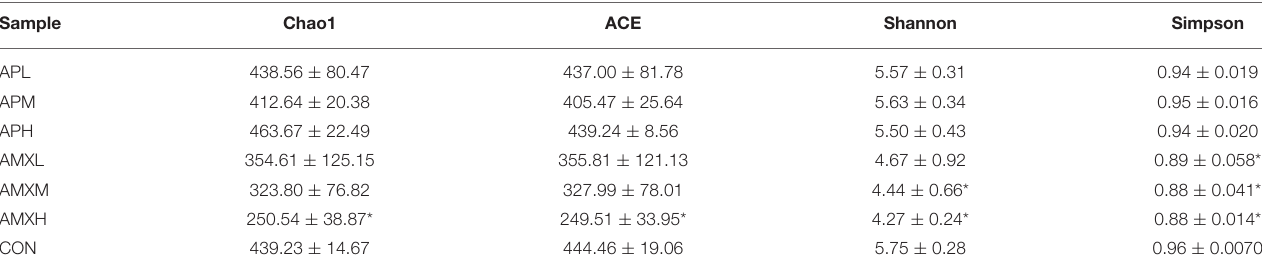
TABLE 2 | Microbial diversity index analysis.